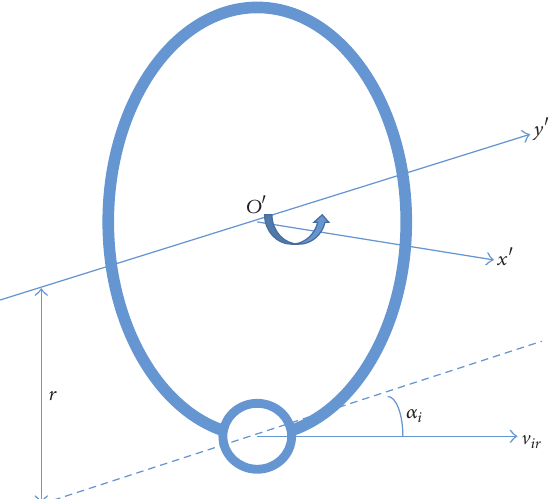
Figure 1: The structure of 𝑖 omnidirectional wheel. Figure 2: The motion relationship between system center and the 𝑖 omnidirectional